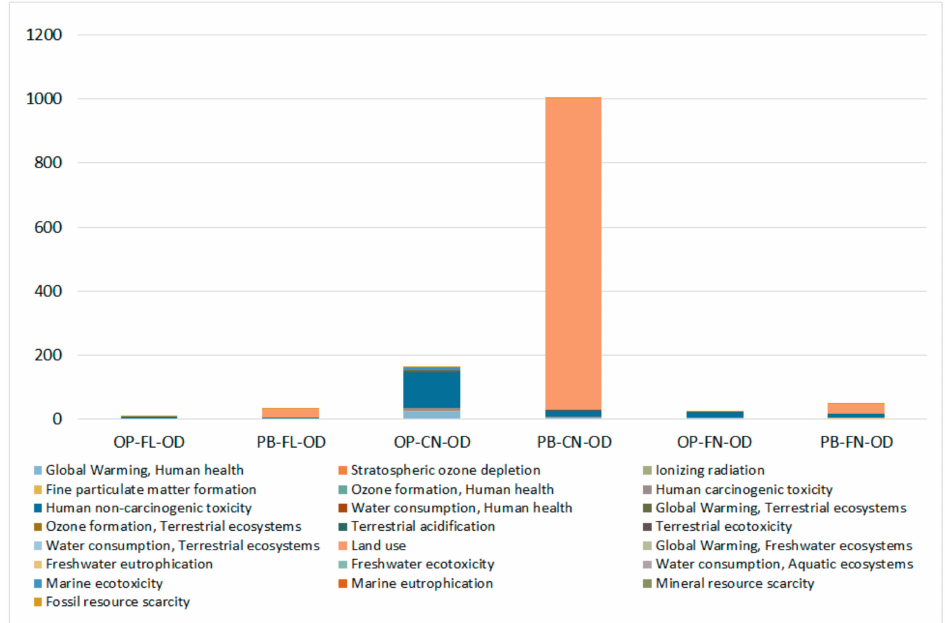
Figure 2. Life cycle environmental impacts of each upstream process path for 1 kg biodiesel (OP— open pond; PB—photobioreactor; FL—flocculation; CN—centrifugation; FN—filtration; OD—oven